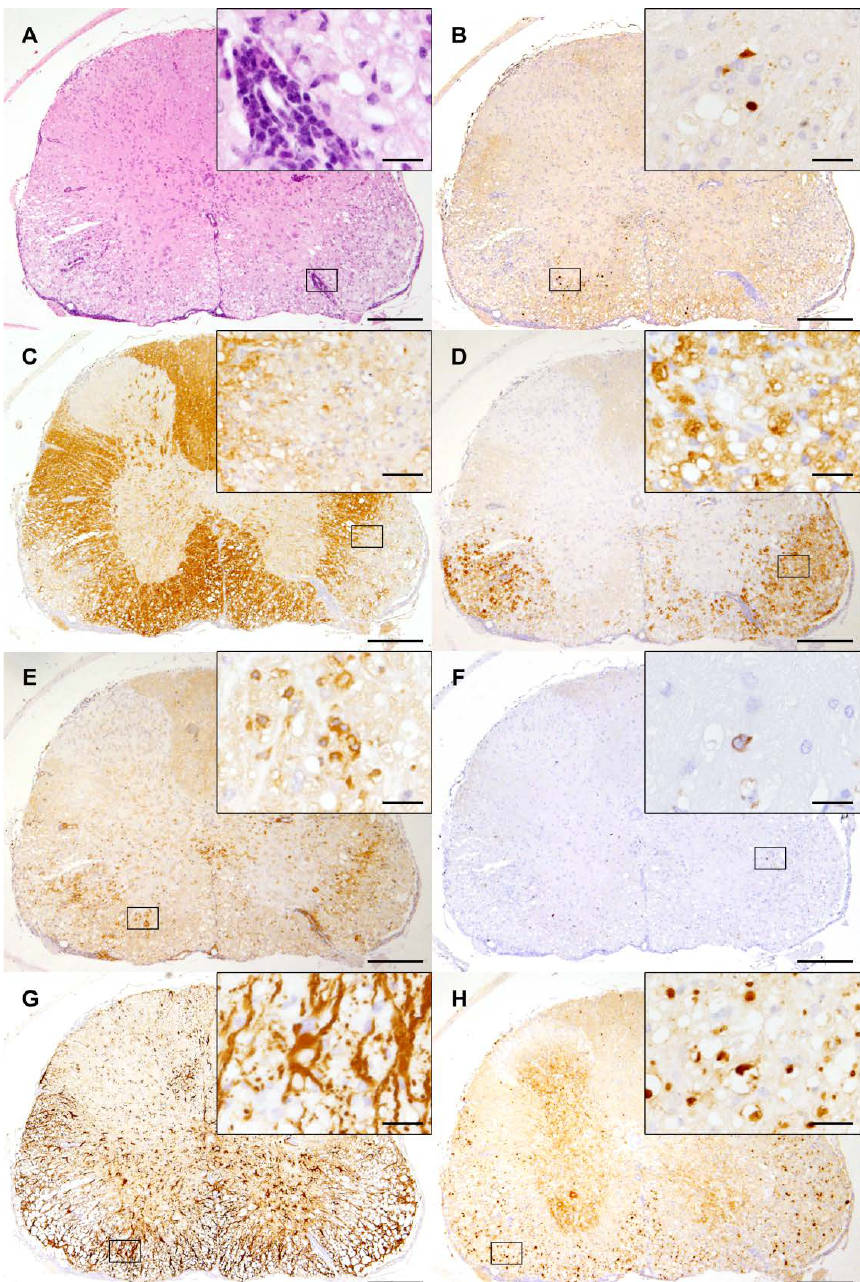
Figure 2. Spinal cord lesions induced by Theiler’s murine encephalomyelitis virus in SJL mice: ( A ) Spinal cord lesions at 14 weeks post infection consist of mononuclear meningomyelitis centered in the ventral white matter (hematoxylin eosin staining). ( B ) The immunohistochemistry of spinal cord lesions reveals virus protein mainly located in the ventrolateral funiculus. ( C ) Demyelination is illustrated by a loss of myelin basic protein staining. ( D ) Myelin debris is removed by activated microglia/macrophages (MAC3/CD107b). ( E ) Abundant T cells (CD3) infiltrate spinal cord lesions. ( F ) Only low numbers of B-lymphocytes (CD45R) are present in the TMEV-infected spinal cord. ( G ) Astrogliosis (GFAP) with numerous activated astrocytes is present in spinal cord lesions. ( H ) Axonal degeneration is characterized by the accumulation of non-phosphorylated neurofilaments and spheroid formation. (A – H) The inserts show higher magnifications of the areas delineated by the black rectangles. The bars represent 200 µm and 20 µm for overviews and inserts, respectively.